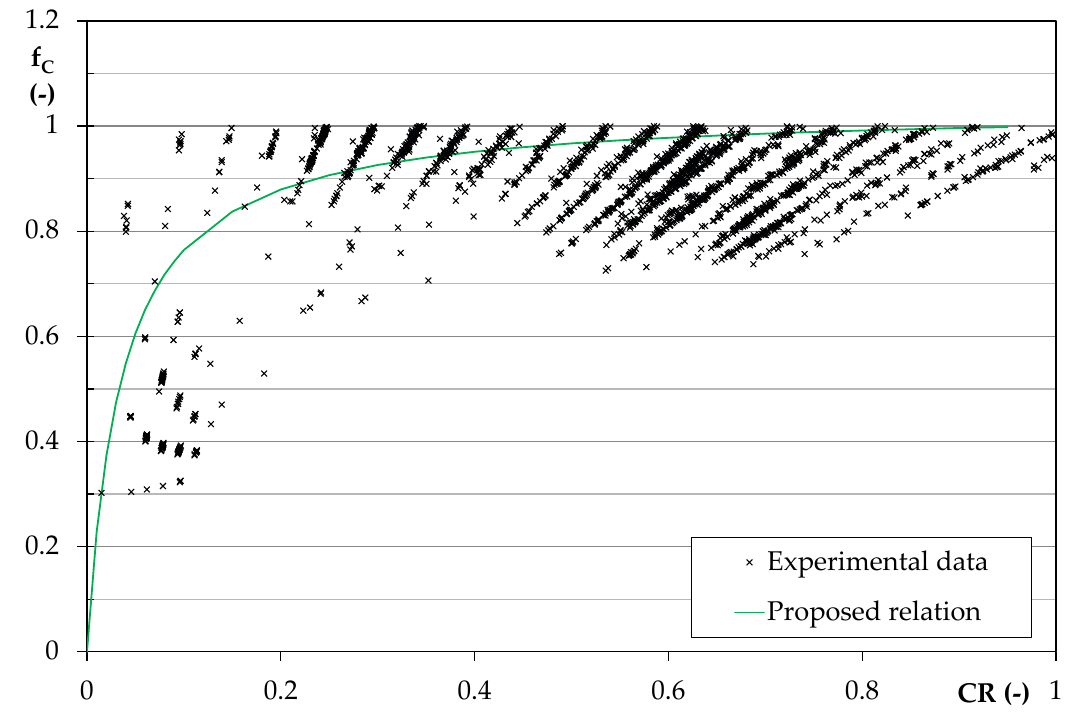
Figure7. Figure 7. Summer experimental data and comparison with the trend describing the proposed correlation.